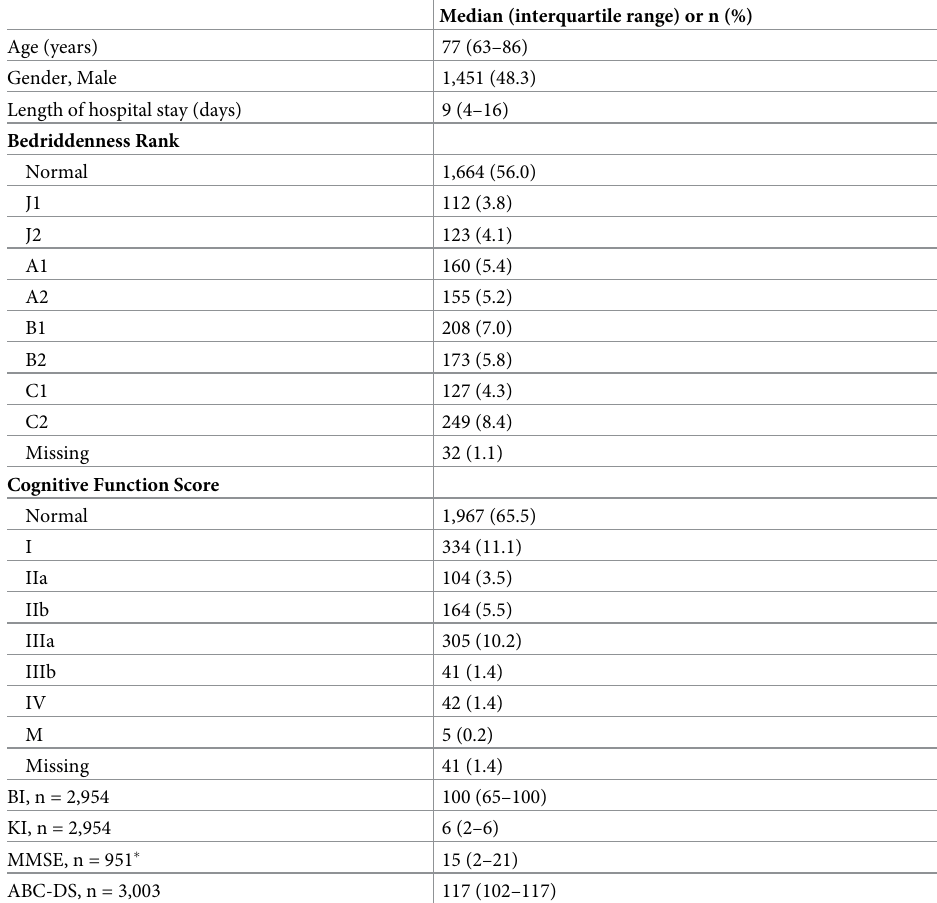
Table 1. Characteristics of enrolled